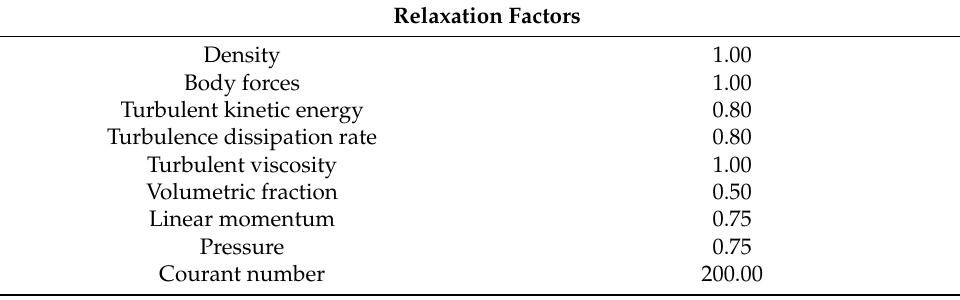
Table 3. Ansys Fluent standard relaxation factors.